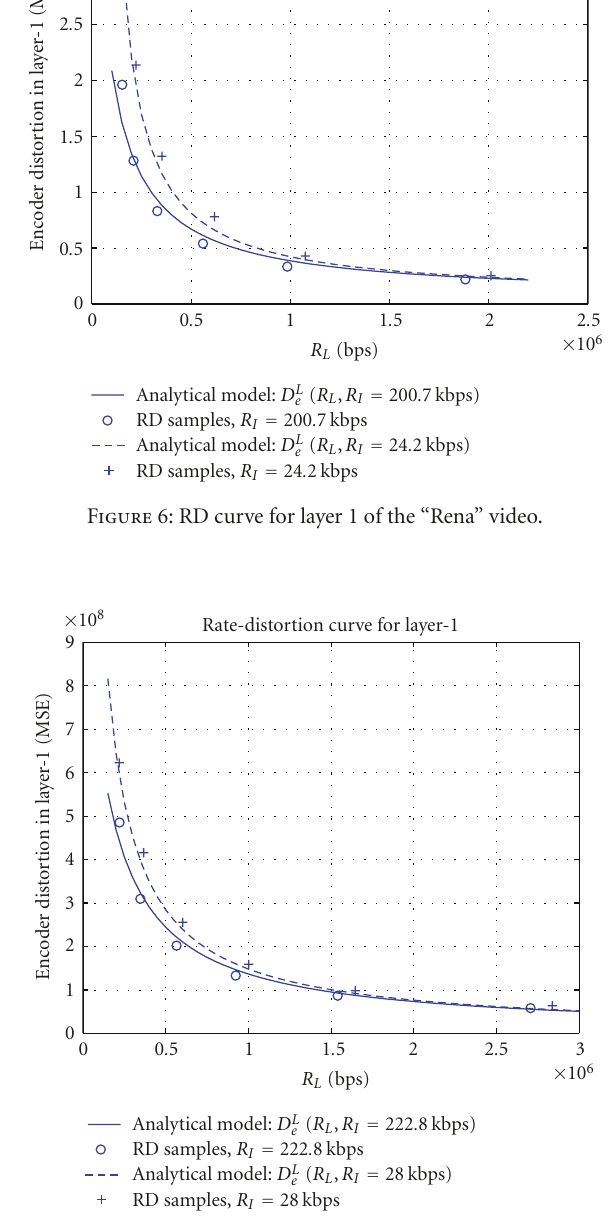
Figure 7: RD curve for layer 1 of the “Soccer” video.